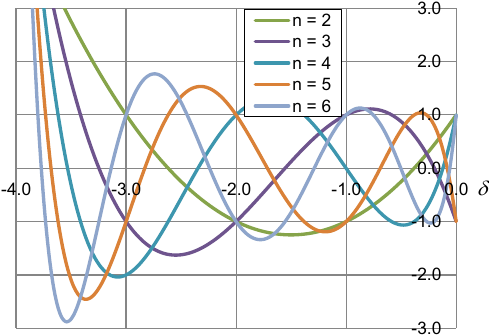
Figure 3. Graphs W n (δ) at different numbers of reservoirs n ; the value of k for the last reservoir in a chain is doubled (model